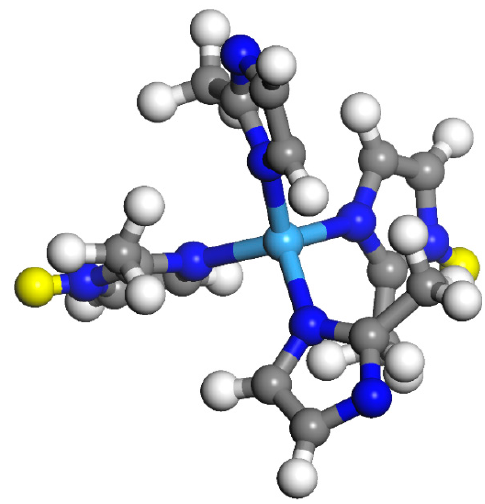
Figure 2. Cluster model used to simulate ZIF-8 structure, as optimized at the B3LYP-D3 / TZVP level. Color code as in Figure 1. The yellow spheres are used to represent the protons used to saturate the dangling bonds of the model.